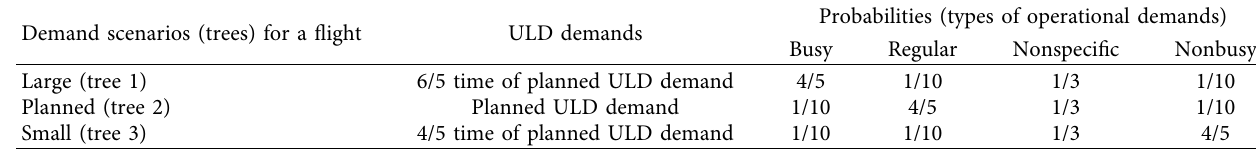
Table 4: ULD demands and probabilities of demand scenarios for a flight.